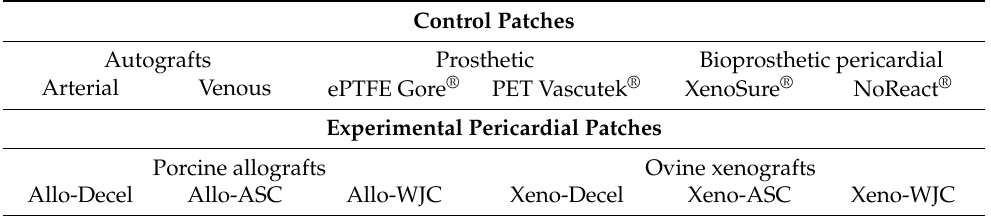
Table 1. A list of the control and experimental pericardial decellularized and recellularized patches.